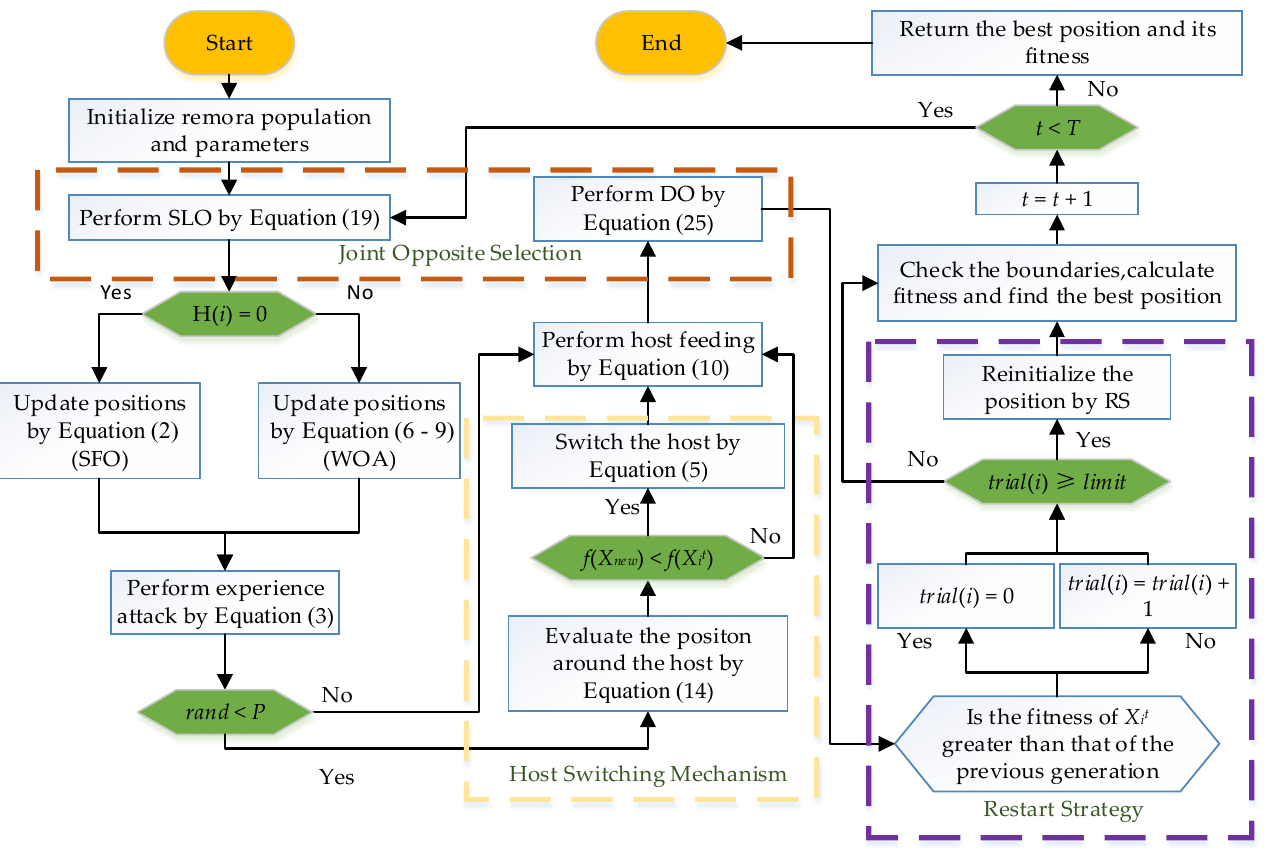
Figure 3. The flowchart of the MROA.